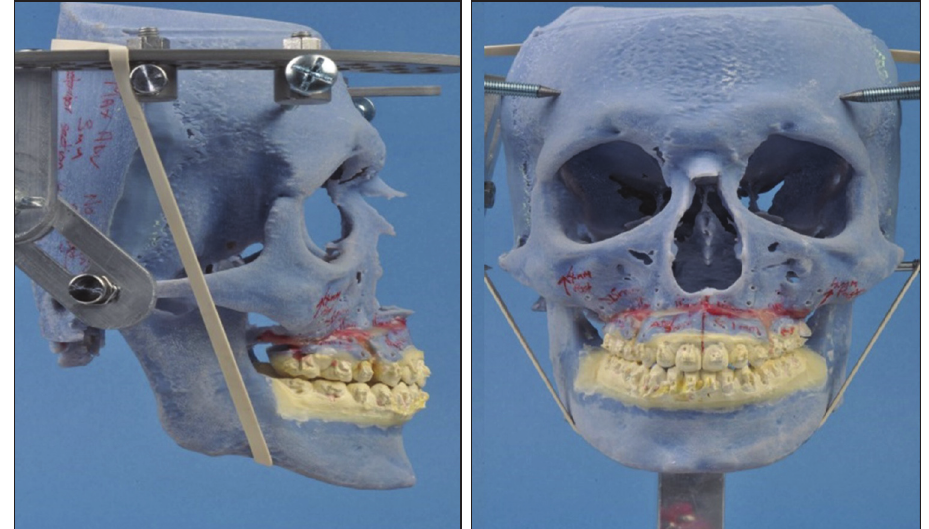
Figure 9. Final physical skeletal and dental plan with accurate replaced dentition.